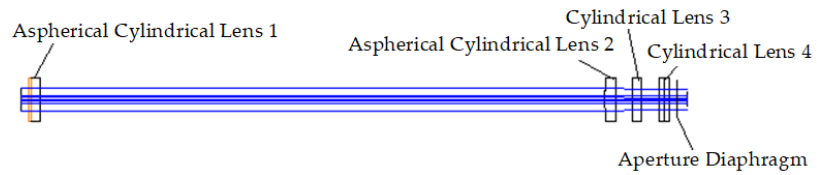
Figure 11. Optical structure of the focusing lens system.